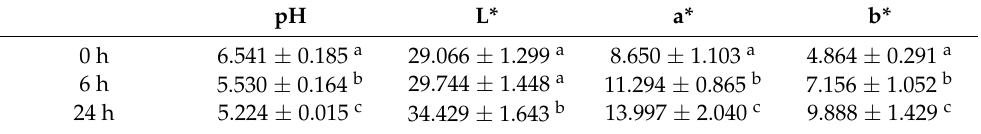
Table 1. pH and meat color of Longissimus lumborum muscles during postmortem storage. pH